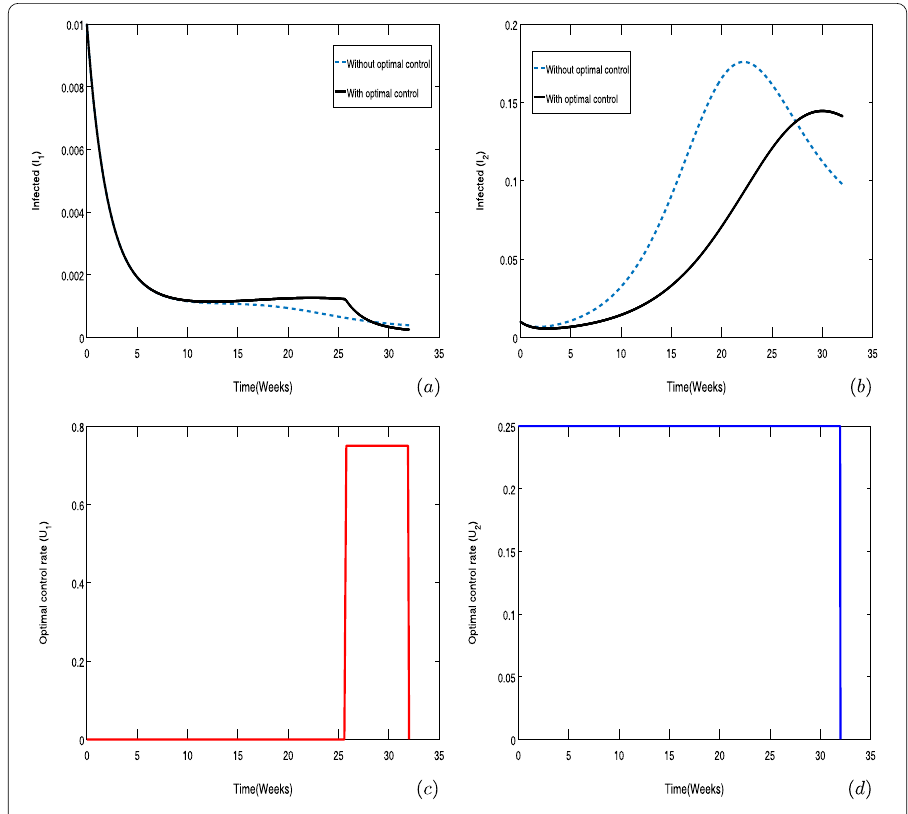
Figure 3 Time series plots showing the effects of optimal control on the ( a ) infected individuals for patch 1 ( I 1 ), ( b ) infected individuals for patch 2 ( I 2 ); also the optimal control graphs for the two controls, ( c ) educational campaigns for patch 1 and ( d ) educational campaigns for patch 2